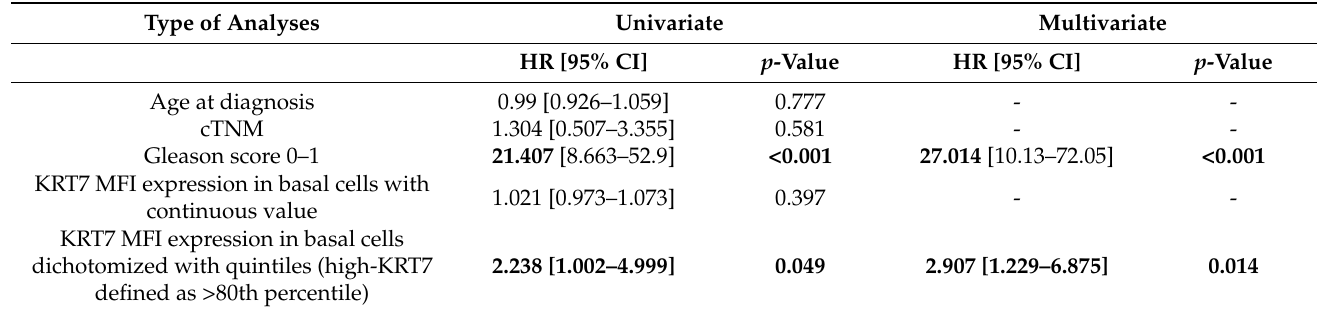
Table 1. Univariate and multivariate Cox regression analyses of Gleason score and KRT7 expression (either continuous value or dichotomized with quintiles) in basal cells to predict bone metastasis free